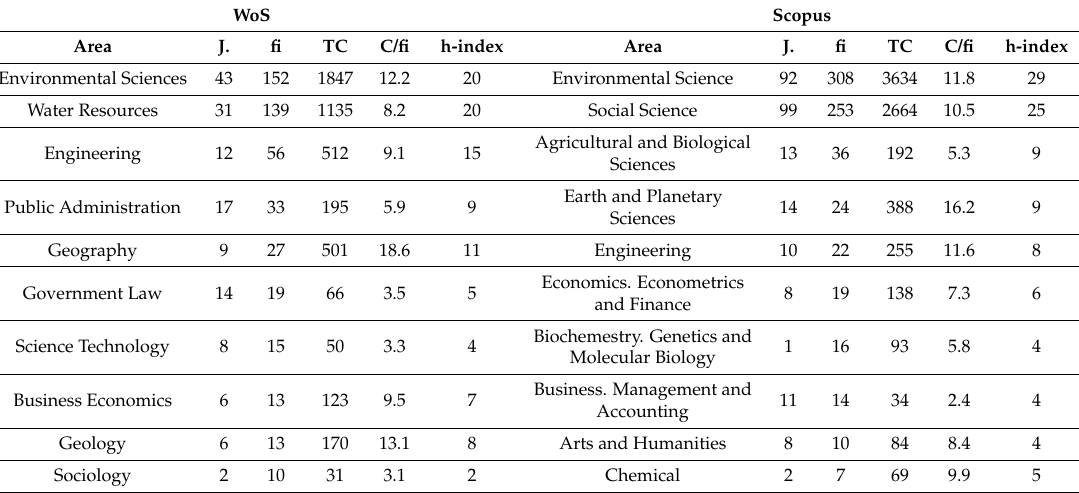
Table 6. Main Subject